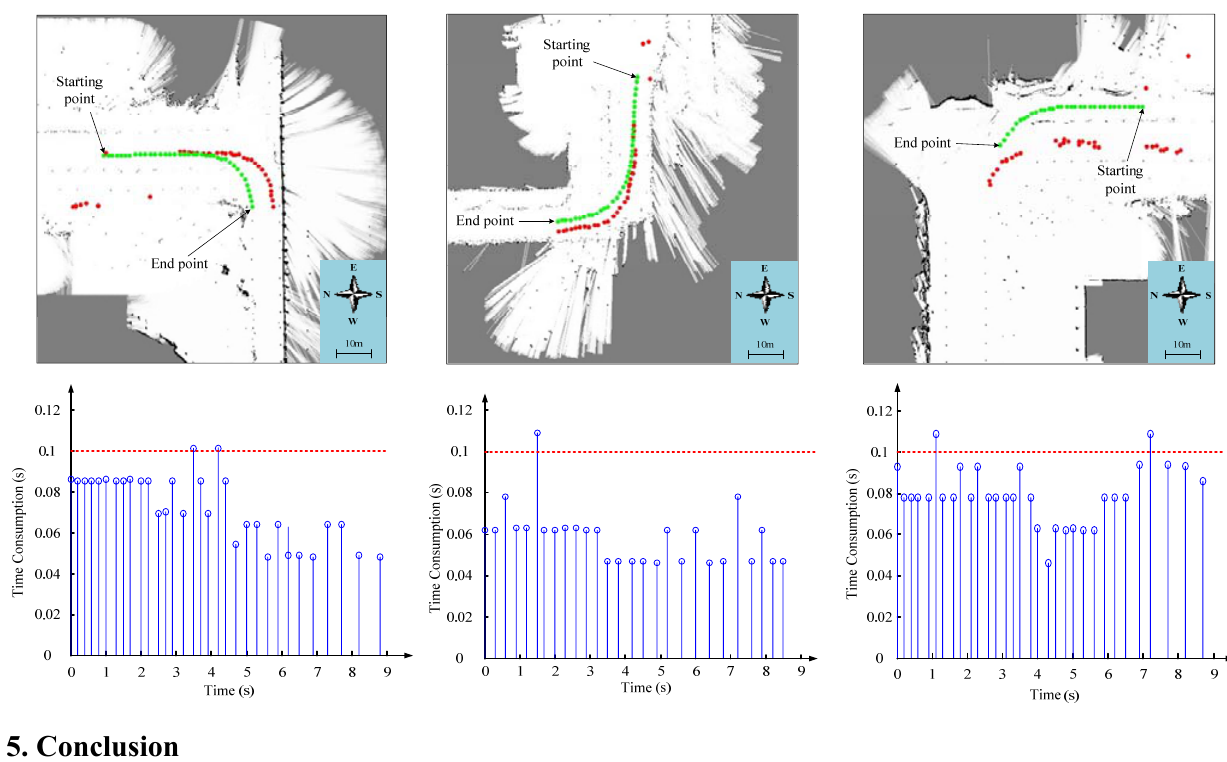
Figure 13. Window constraint Markov localization in loose constraint